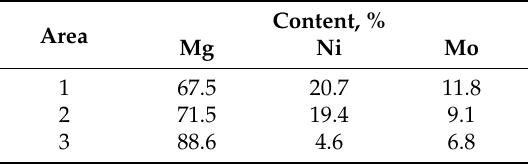
Table 2. EDX data for the areas shown in Figure